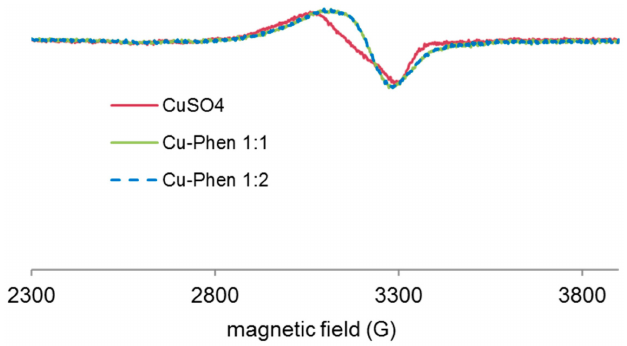
Figure 16. Experimental X-band EPR spectra recorded at 100 K in frozen aqueous solutions of CuSO 4 and Cu-Phen at pH 6.5, with Cu:Phen molar ration = 1:1 and 1:2 and [Cu] = 1.5 mM.